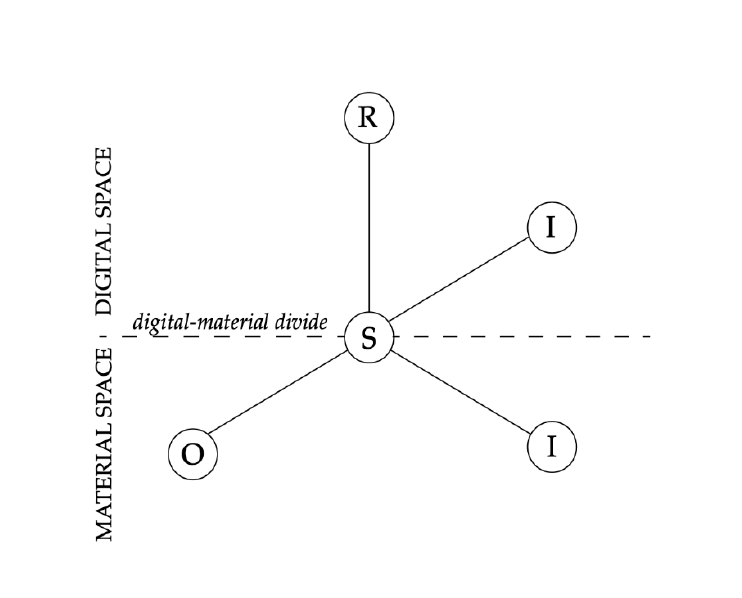
Figure 2. Peirce’s triadic sign model and in digital and material